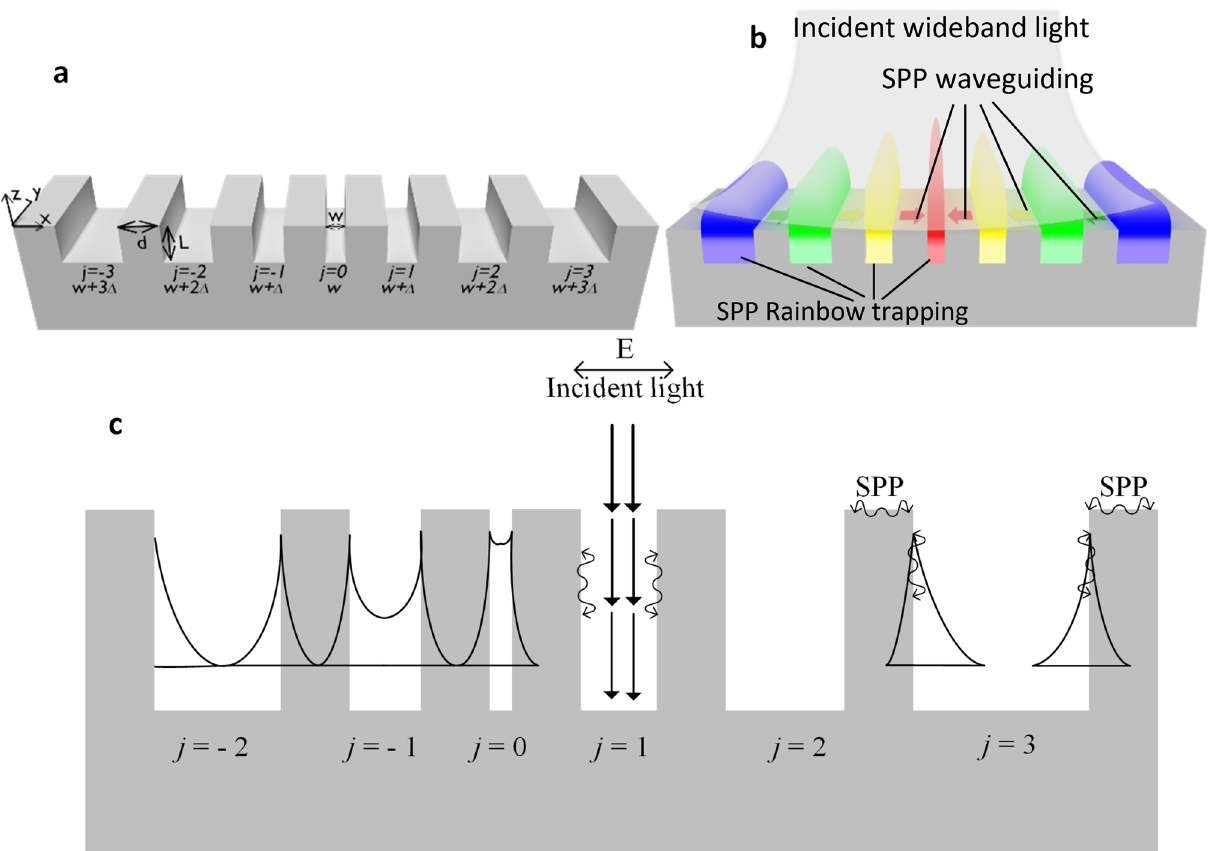
Figure 1. ( a ) Schematic of an MIM-based grating with W , d , L and Δ representing groove width, groove-to- groove separation, groove depth and the width gradient, respectively; j is the groove number. This structure represents a width-graded nano-grating which is symmetric around the centrally situated groove j = 0. ( b ) A cartoon illustration of rainbow trapping in the plasmonic width nano-grating; smaller the groove width, larger the wavelength of the localized field. Also, effect of SPPs waveguiding on top of the grating in the direction of increased effective index atop the grating is illustrated by the arrows on the surface, and the increasing intensity of the localized field at smaller groove widths. Gradient in the trapped field intensity shows the location of hotspots within and on top of the grooves. (Not to scale.) ( c ) Illustrating various coupling mechanisms for mode localization. For brevity, every groove showcases a potential mode coupling mechanism which in general can occur in any other groove. Grooves denoted as j = -2 and j = 0 show the weak and strong coupling between the SPPs excited on the opposing side-walls of the groove, respectively. The evanescent mode coupling from adjacent grooves is shown for groove j = − 1, specifically coupling with adjoining grooves j = − 2 and j = 0. Groove j = 1 shows the coupling of incident light with the cavity mode. Groove j = 3 shows coupling of surface waves with the cavity modes and thus exciting SPPs on the groove’s inner walls. (Not to scale.). ( a , b ) were drawn in Community, B. O. (2018). Blender —a 3D modeling and rendering package. Stichting Blender Foundation. Retrieved from http://www.blend er.org. ( c ) was draw in Microsoft Corporation (2016). Microsoft Visio. Retrieved from https ://produ cts.offic e.com/en/visio /flowc hart-softw